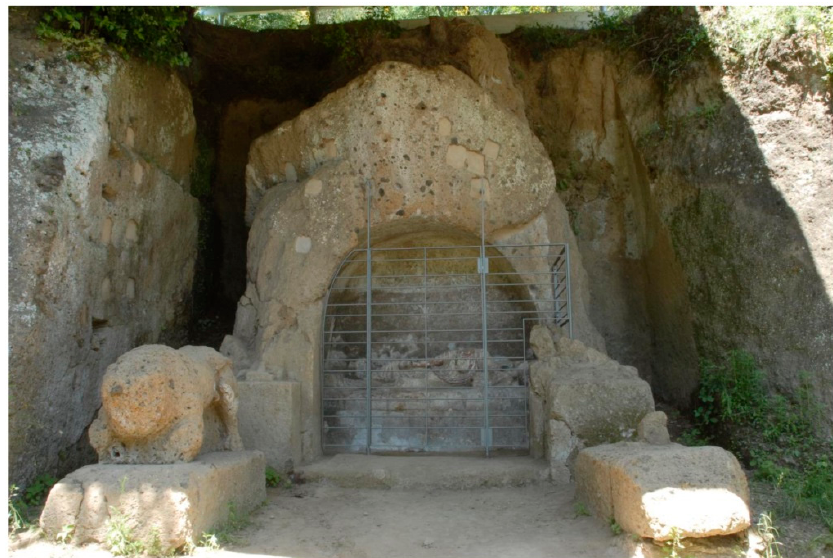
Figure 2. The Tomba dei Demoni Alati after the restoration.